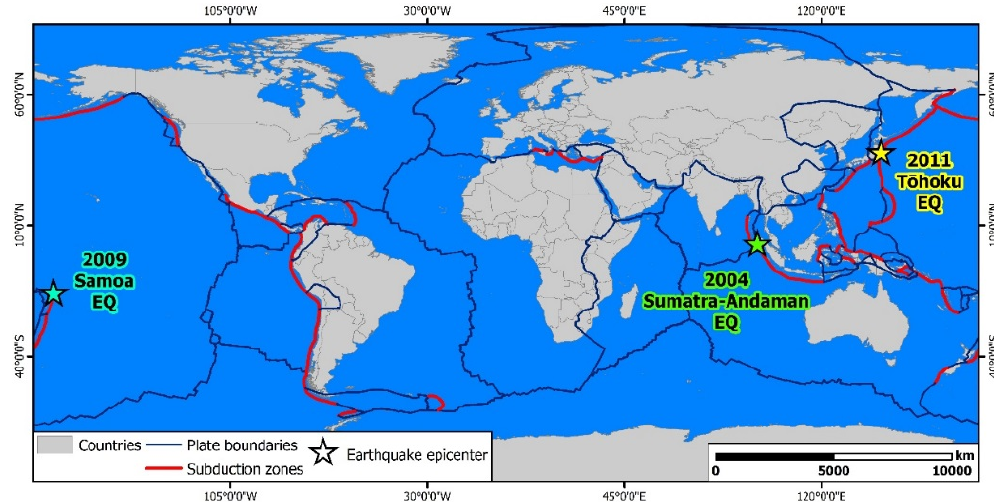
Figure 2. Epicenters of the earthquakes that caused the most devastating tsunami in recent history. More specifically, the Mw = 9.2, 26 December 2004 Sumatra—Andaman earthquake triggered the Indian Ocean tsunami, the Mw = 8.1, 29 September 2009 Samoa earthquake triggered the Samoa tsunami and the Mw = 9.0, 11 March 2011 T ō hoku (Japan) earthquake generated the Great East Japan tsunami.